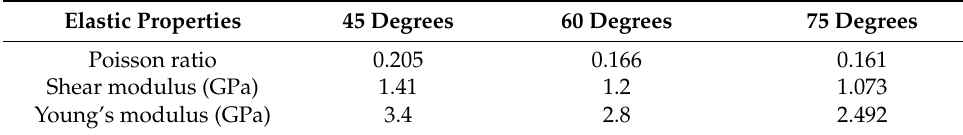
Table 3. Epoxy sample readings at varying